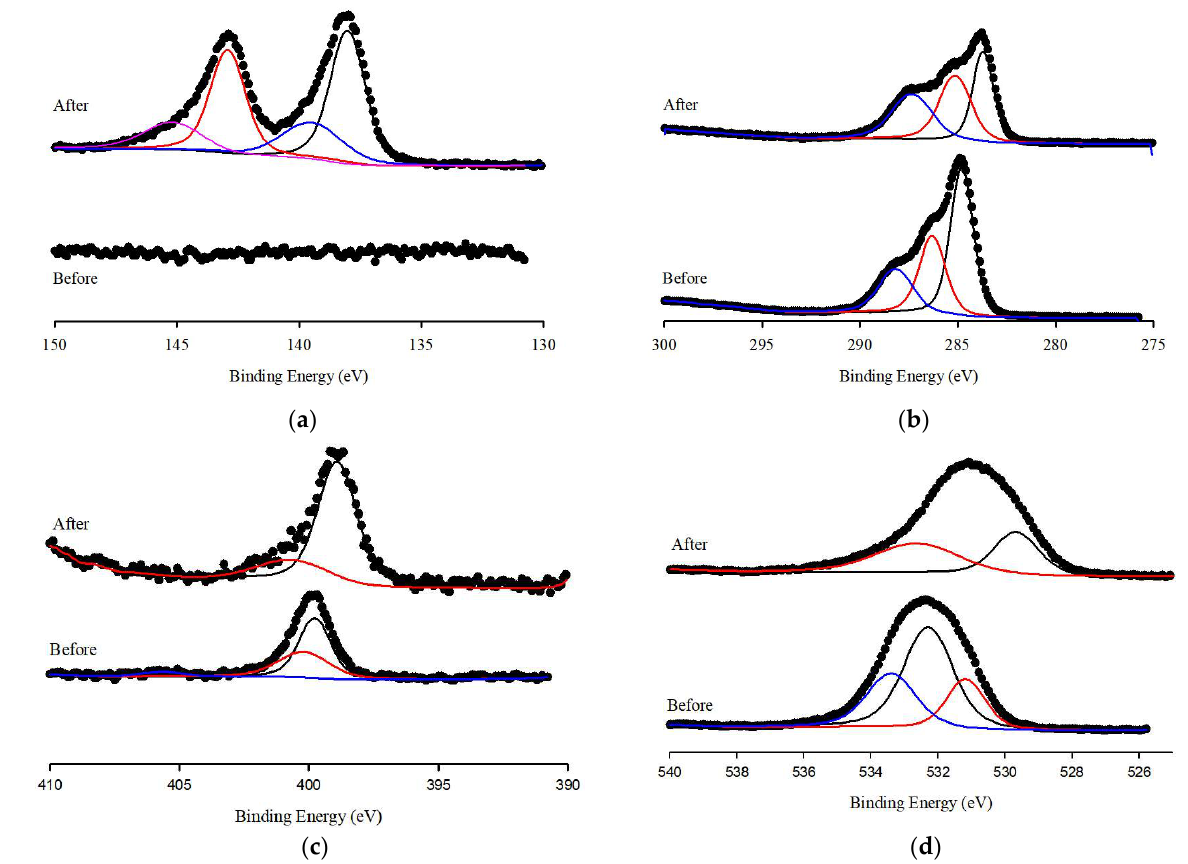
Figure 6. XPS spectrum of ( a ) Pb 4f, ( b ) C 1s, ( c ) N 1s and ( d ) O 1s of S.P@Ca-SA before and after reaction.